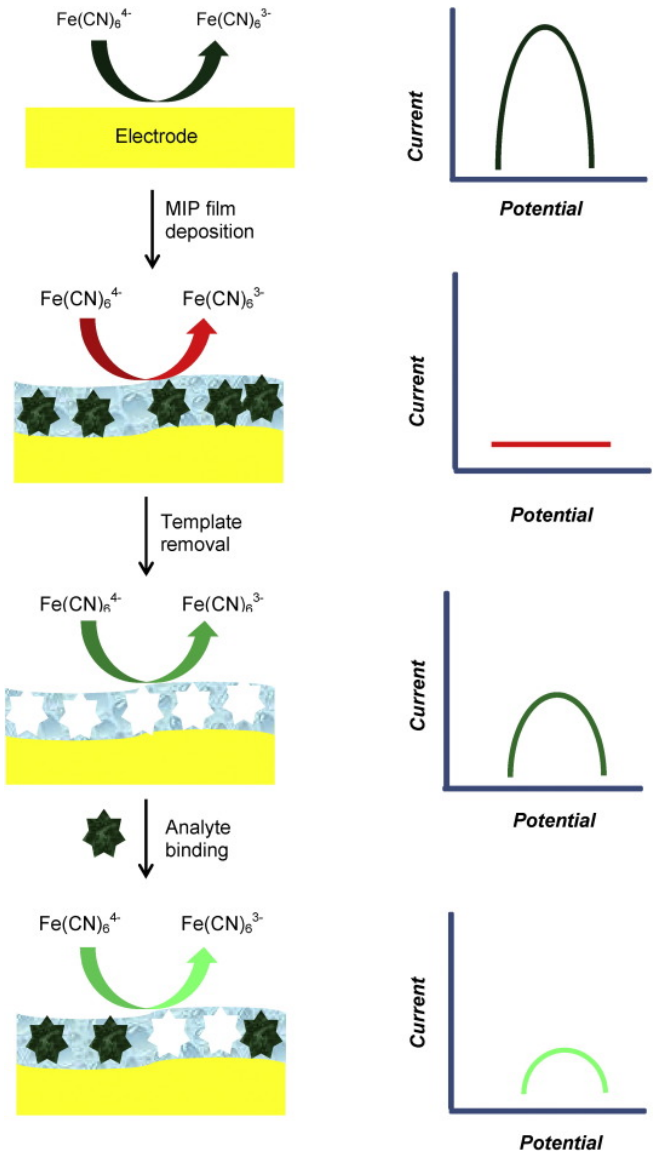
Figure 12. Examples of using “gating effect” for indirect electrochemical detection of the analyte at the MIP-based electrode and the corresponding current-potential signals. Reprinted with permission from [15]. Copyright 2016 Elsevier.